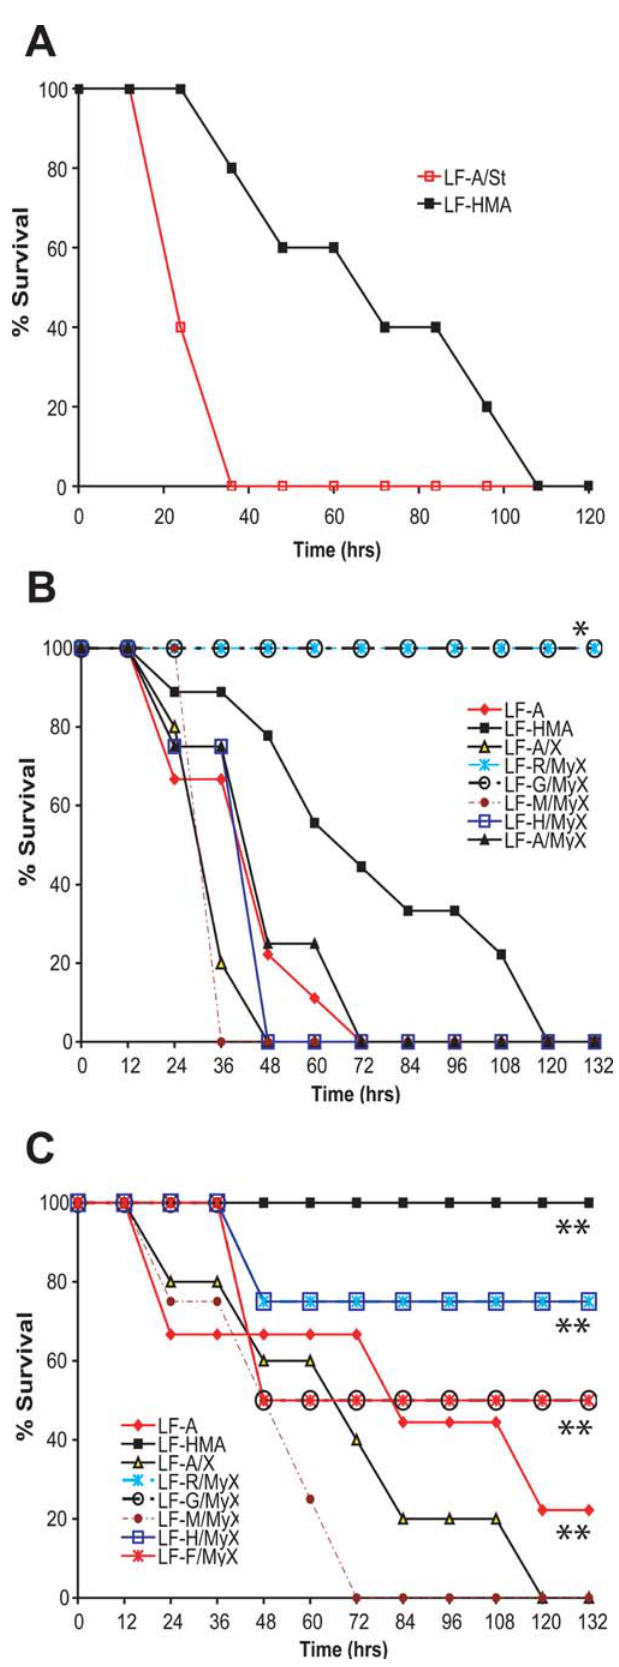
Figure 3. Toxicity of LF proteins to mice. (A) LF-HMA and LF-A/St (100 m g) were injected in Balb/cJ mice in combination with 100 m g PA via the IP route and survival was monitored for 120 h. Each group contained n=5 mice. (B) LF proteins (100 m g) were injected in Balb/cJ mice in combination with 100 m g PA via the IP route and survival was monitored for 120 h. Mouse numbers used in this experiment were as follows: LF-HMA (n=9), LF-A (n=9), LF-A/X (n=5), LF-G/MyX (n=3) and all other groups n=4. (*) The animals in LF-G/MyX and LF-R/MyX groups exhibited substantial malaise starting at 24 h and throughout the experiment and were euthanized at 128 h to prevent suffering in accordance with approved animal protocols. (C) LF preparations (40 m g) were injected in Balb/cJ mice in combination with 40 m g PA via the IP route and survival was monitored for 120 h. Mouse numbers used in this experiment were as follows: LF-HMA (n=14), LF-A (n=9), LF-A/X (n=5) and all other groups n=4. (**) The surviving animals in these groups did not display any signs of malaise over the last 48 h of the